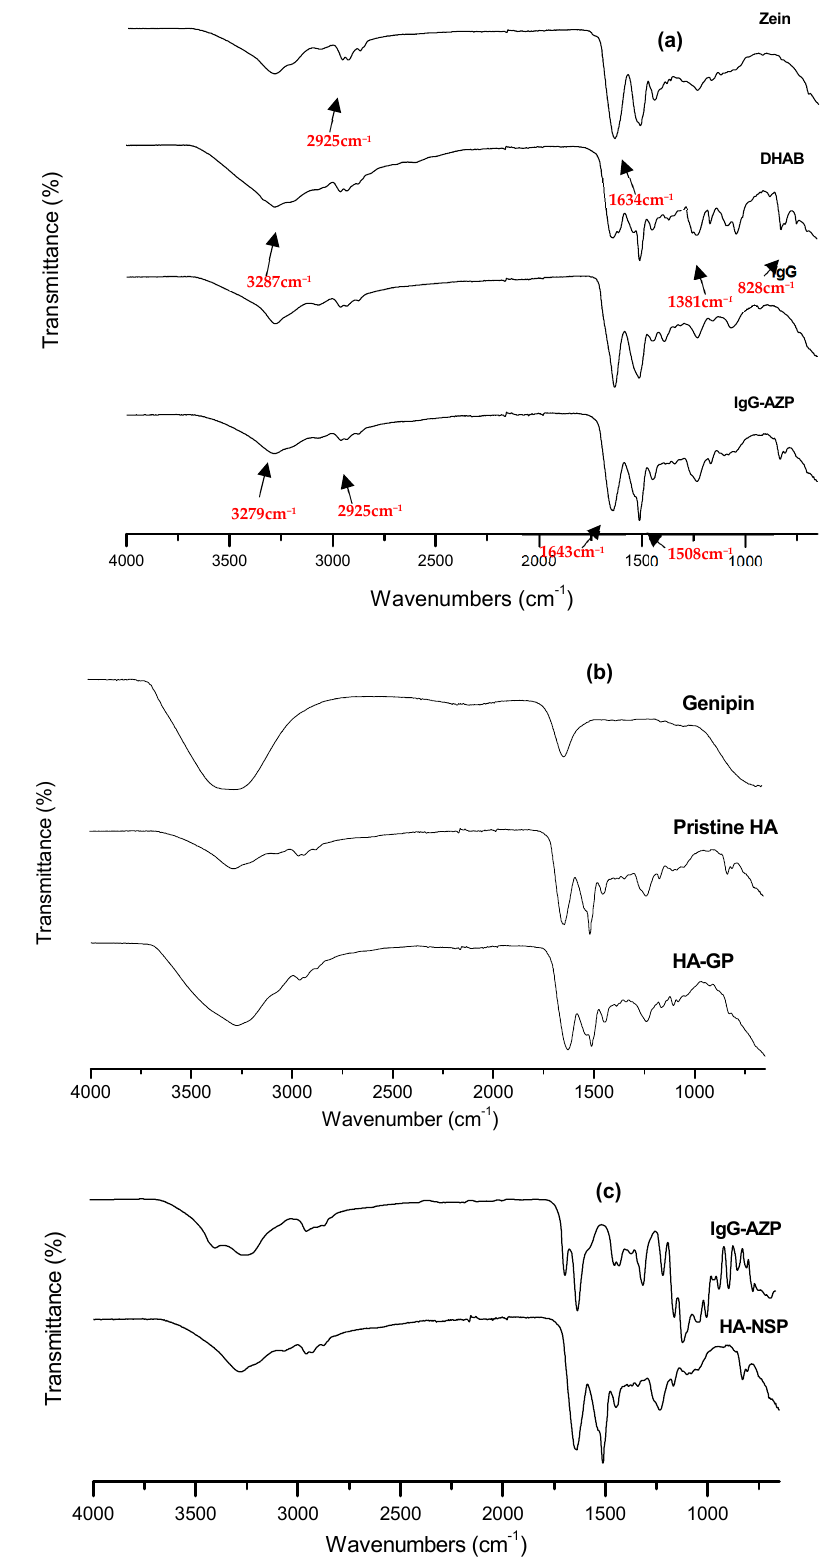
Figure 5. FTIR spectra of ( a ) Zein, DHAB, IgG and IgG loaded AZP nanospheres, ( b ) Genipin, Pristine HA and genipin crosslinked HA hydrogel and ( c ) IgG loaded AZP nanospheres and HA-NSP